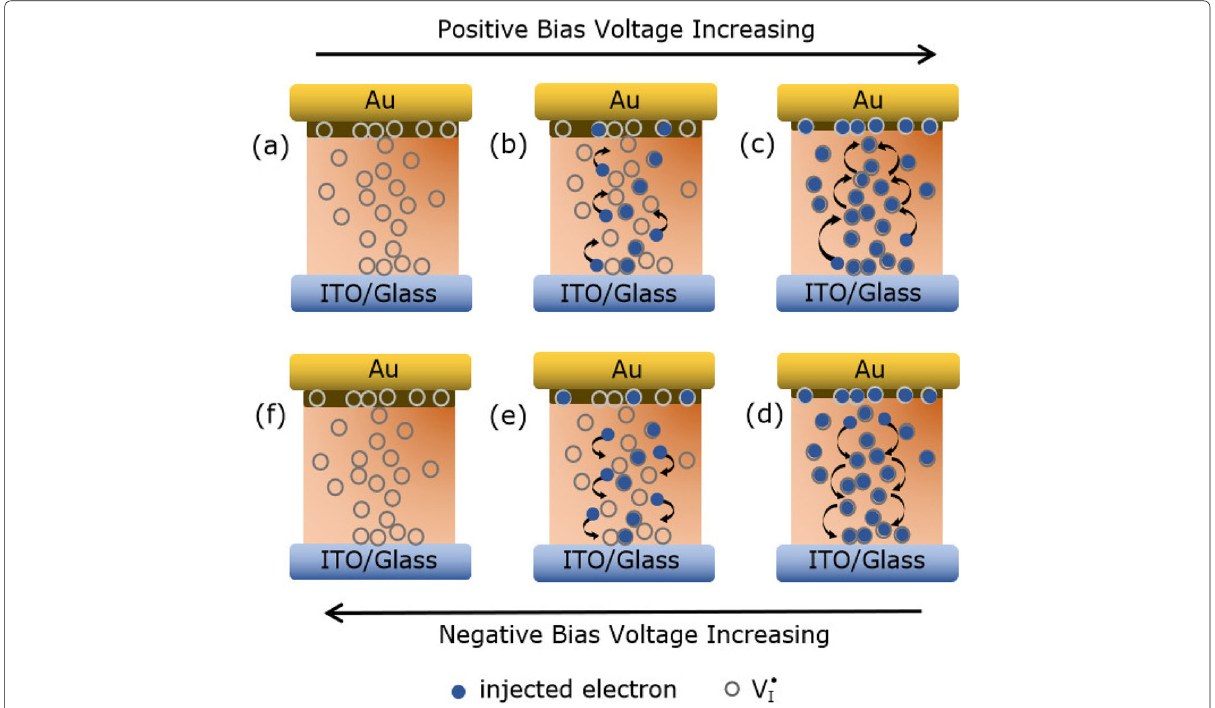
Fig. 7 a – f The schematic of the RS mechanism model in the Au/KCl-MAPIC/ITO/glass cell